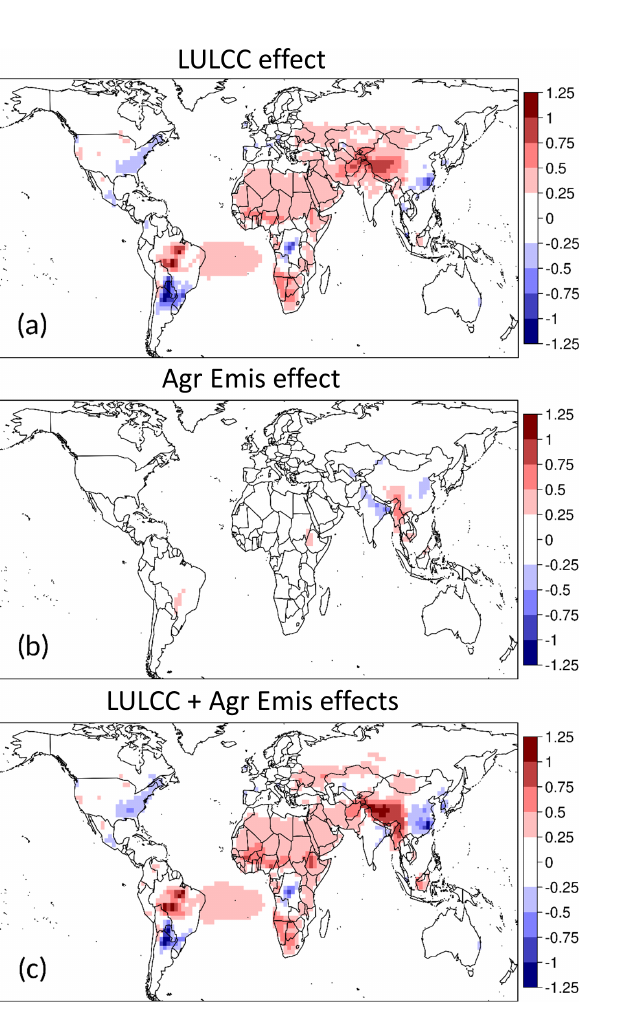
Figure 6. Simulated changes in annual mean surface O 3 due to (a) LULCC, (b) agricultural emission (“Agr Emis”) changes, and (c) the combined effects of agricultural emissions and LULCC.